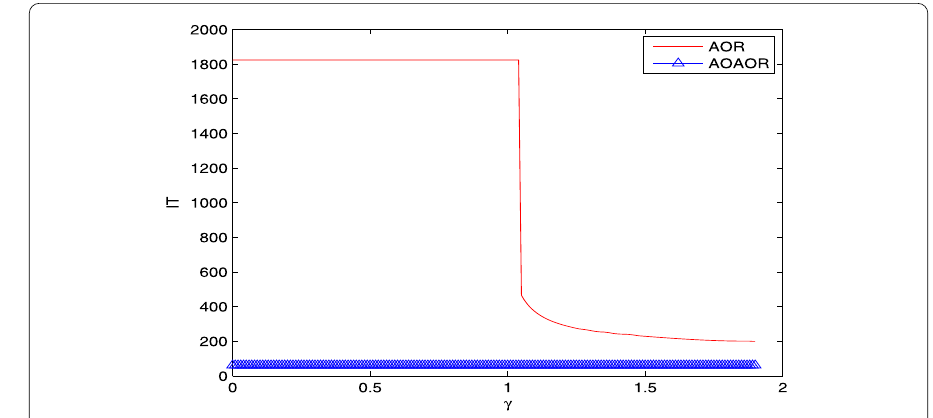
Figure 1 Curves of the IT for ω = 1.9, h –1 = 32 in Table 8.